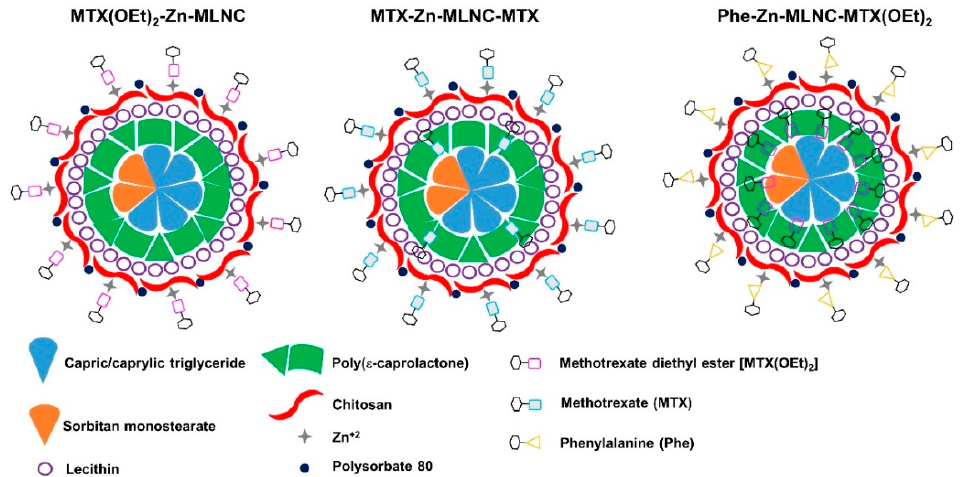
Figure 2. Illustrative models for the supramolecular structures of MTX(OEt) 2 -Zn-MLNC, MTX-Zn-